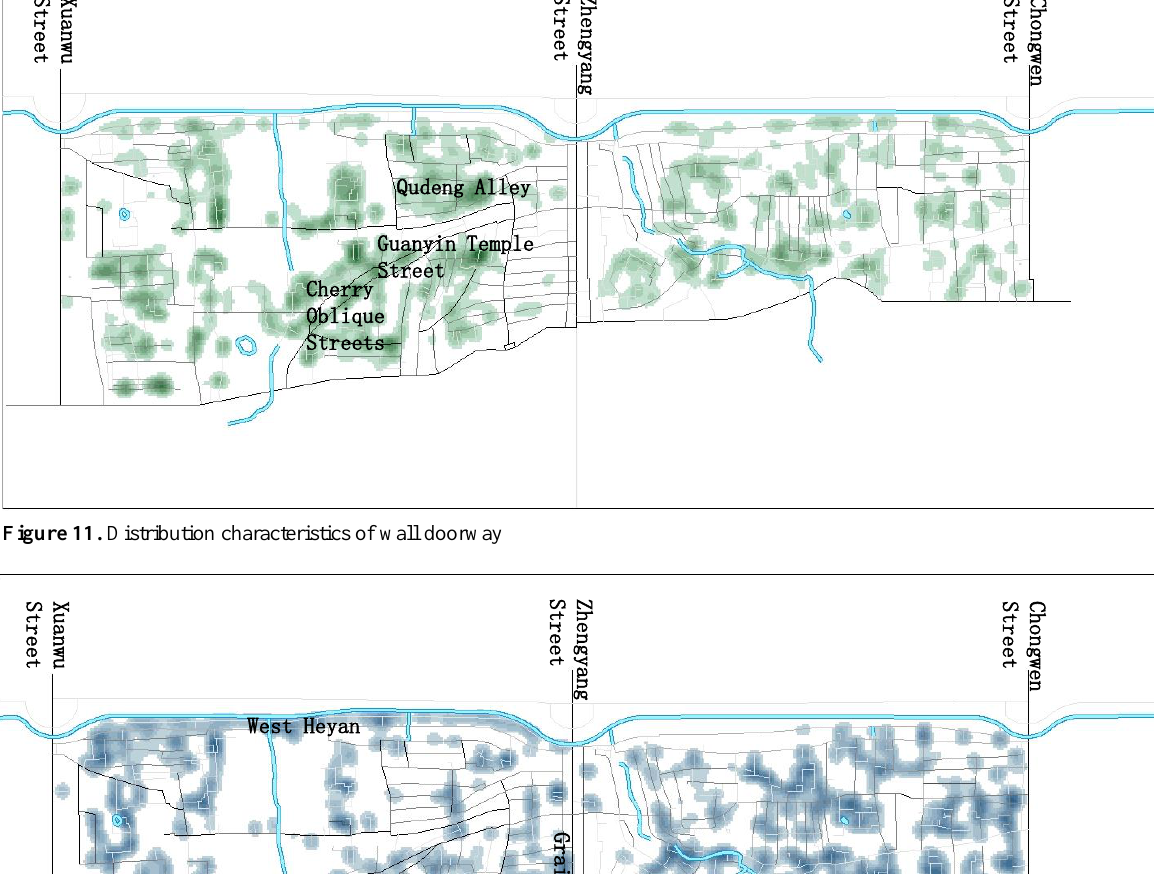
Figure 12. Distribution characteristics of continuous